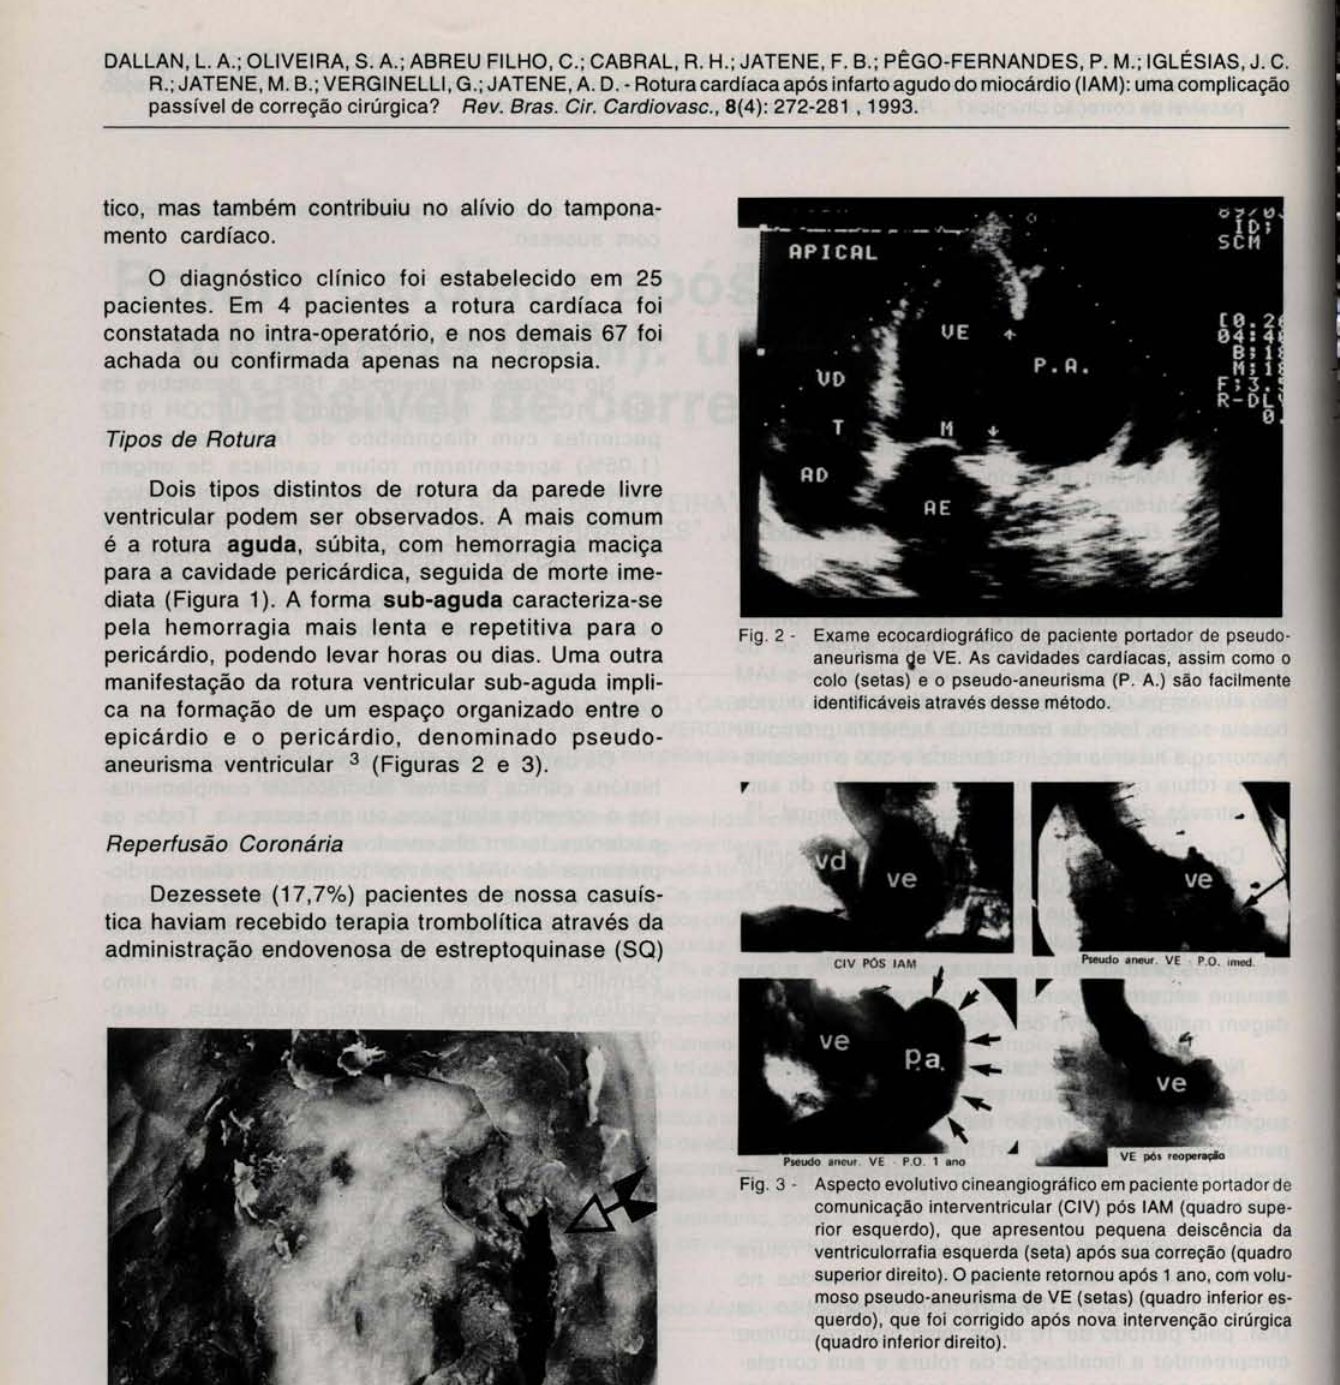
Fig. 1 - Aspecto macroscópio do coração de paciente falecido por rotura cardíaca aguda. Destaca-se a externa laceração em sua parede livre (setas), por onde ocorreu a hemorragia maciça para a cavidade pericardíaca, seguida de tamponamento e morte instantãnea.